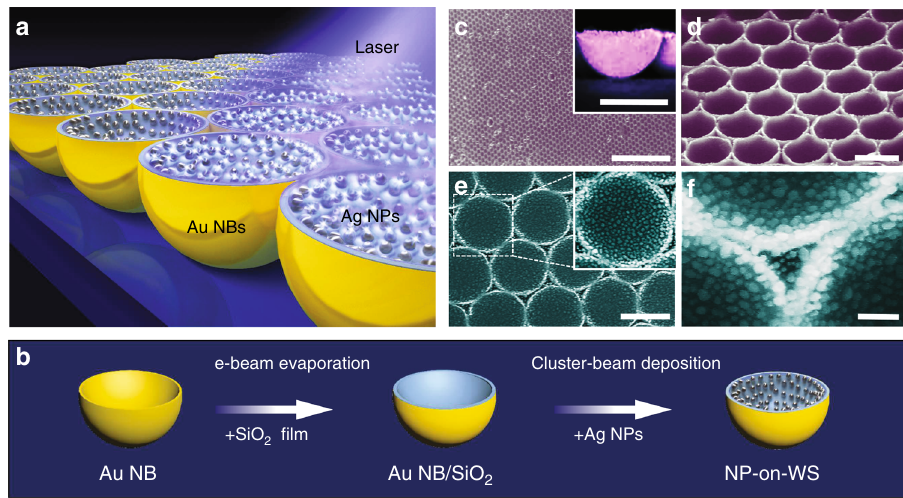
Fig. 2 TO-inspired SERS design and fabrication. a Schematic illustration of SERS substrate con fi guration for nanoparticles on warped substrate (NP-on-WS) hierarchical nanostructure, with nanoparticle acting as nanolens to focus the light to its vicinity and NBs providing additional light con fi nement induced by the curvature. b The fabrication process of hierarchical NP-on-WS nanostructures. A silica fi lm is deposited on Au NB fabricate from silica template. Then a monolayer of nanoparticles is uniformly deposited inside NB by gas-phase deposition. c Low-magni fi ed SEM images of the hexagonal close-packed Au NB array. The scale bar represents 15 µ m. The inset shows a horizontal view of Au NBs with scale bar representing 1 µ m. d Tilted-view SEM images of the hexagonal close-packed Au NB array. The scale bar represents 1 µ m. e Low magni fi cation of experimental realisation of NP-on-WS nanostructure in a . The scale bar represents 1 µ m. f High magni fi cation of experimental realisation of NP-on-WS nanostructure in a . The scale bar represents 200